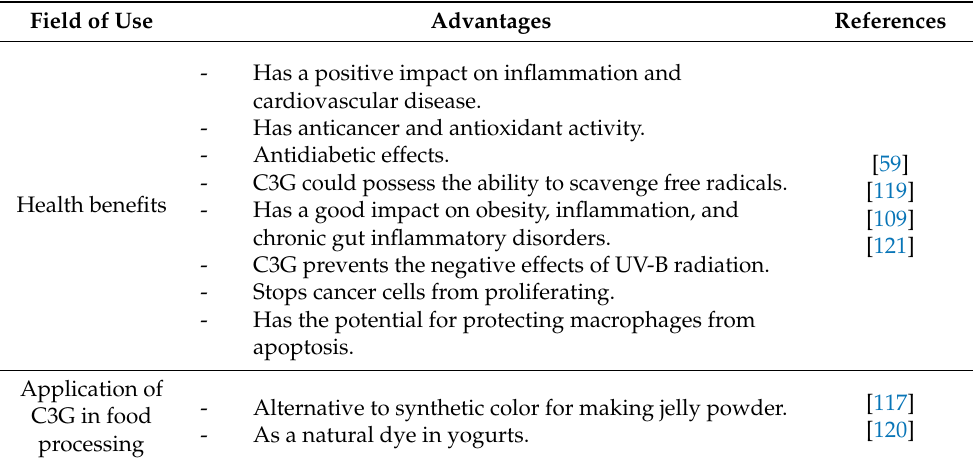
Table 4. Summarization of the health benefits and potential applications of C3G in food processing. Field of Use